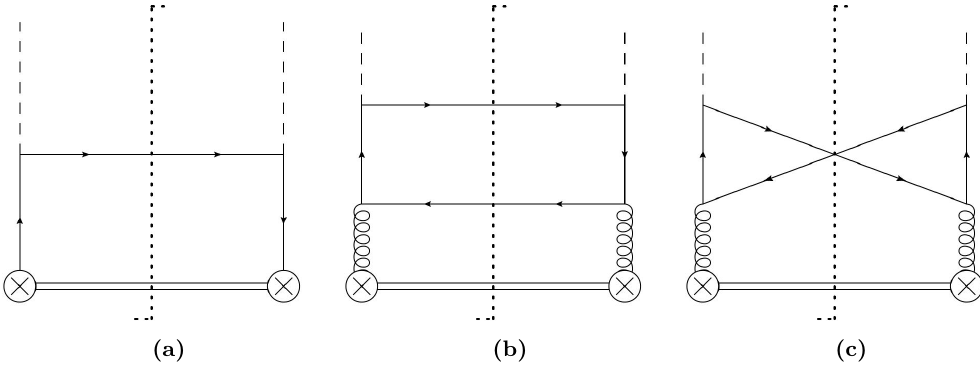
Figure 2. The LO diagram for D t → H (a) and the two diagrams for D g → H at NLO ((b) and (c)). There are also conjugate diagrams to (b) and (c). Lines with arrows denote (anti-)top quarks, curly lines denote gluons and dashed lines denote Higgs bosons. The dotted line in the centre shows the cut, while the double line at the bottom represents the Wilson line. The Higgs-boson line does not cross the cut to symbolise that its momentum is not integrated over. The Feynman diagrams were made using JaxoDraw [64].